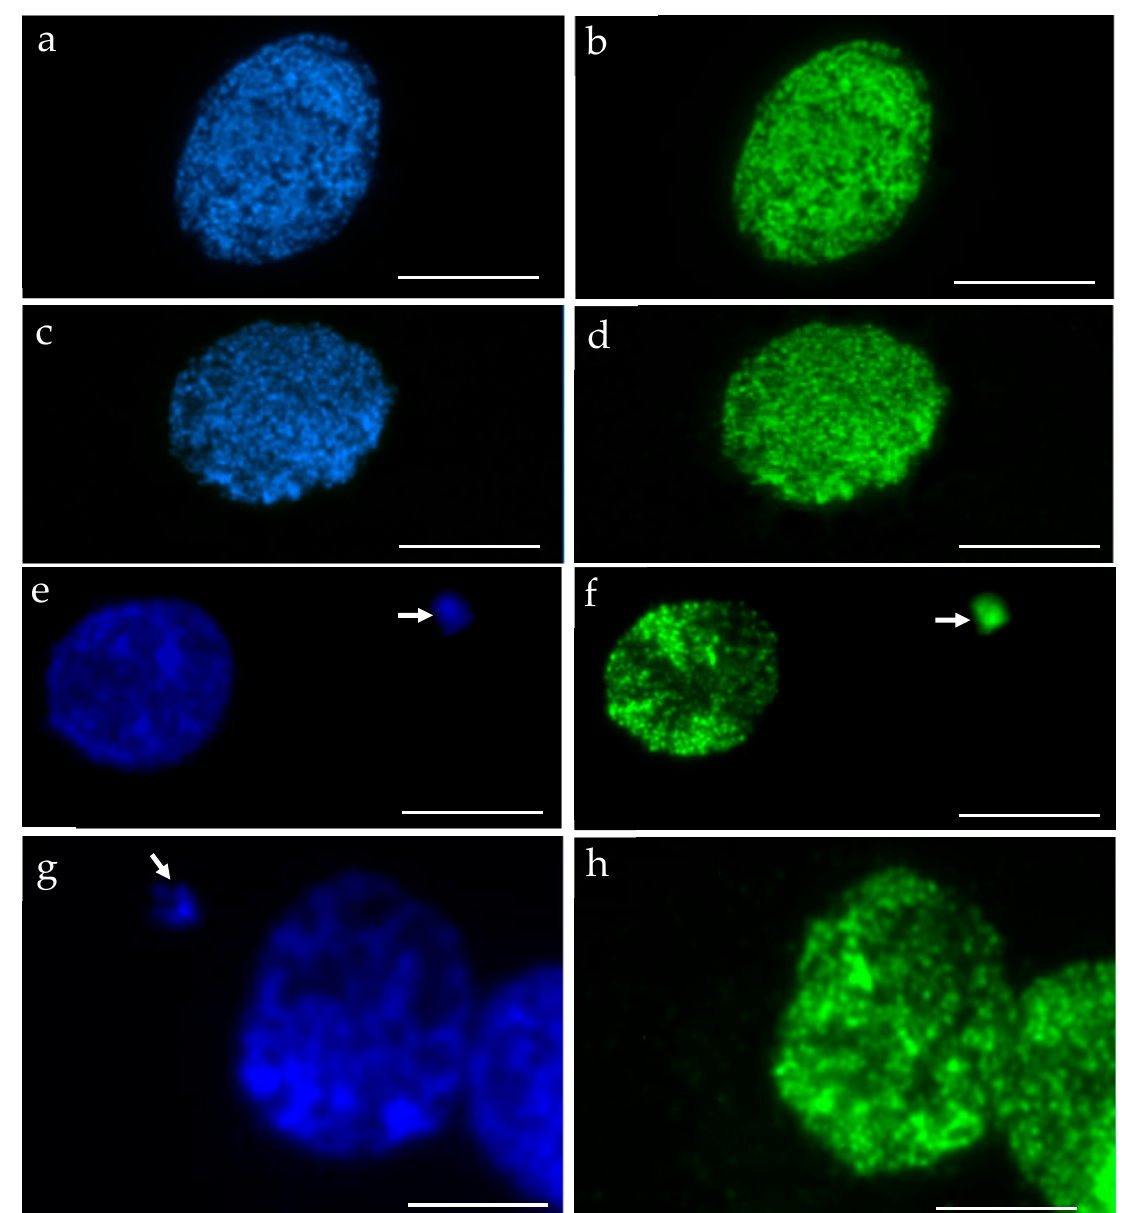
Figure 2. B. distachyon interphase nuclei: DAPI stained, blue ( a , c , e , g ) that were used for the immunocytochemical detection of 5 mC, green ( b , d , f , h ) : ( a , b ) control, ( c – h ) treated with MH. Nuclei without micronuclei ( a – d ) and with micronuclei ( e – h ) were observed. The arrows indicate the micronuclei. The 5 mC signals were always present in the nuclei. Two different kinds of micronuclei were distinguished: those with 5 mC signals ( e , f ) and those without signals ( g , h ). Scale bars = 10 µm.